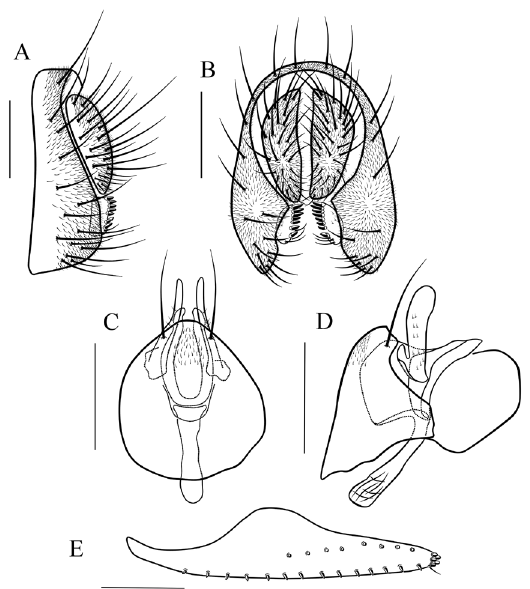
Figure 9. Scaptodrosophila pressobrunnea (Tsacas & Chassagnard, 1976). A, B epandrium, surstylus and cercus (lateral and posterior views) C, D hypandrium, parameres, gonopods, aedeagus and aedeagal apodeme (ventral and lateral views) E oviscapt (lateral view). Scale bars 0.1